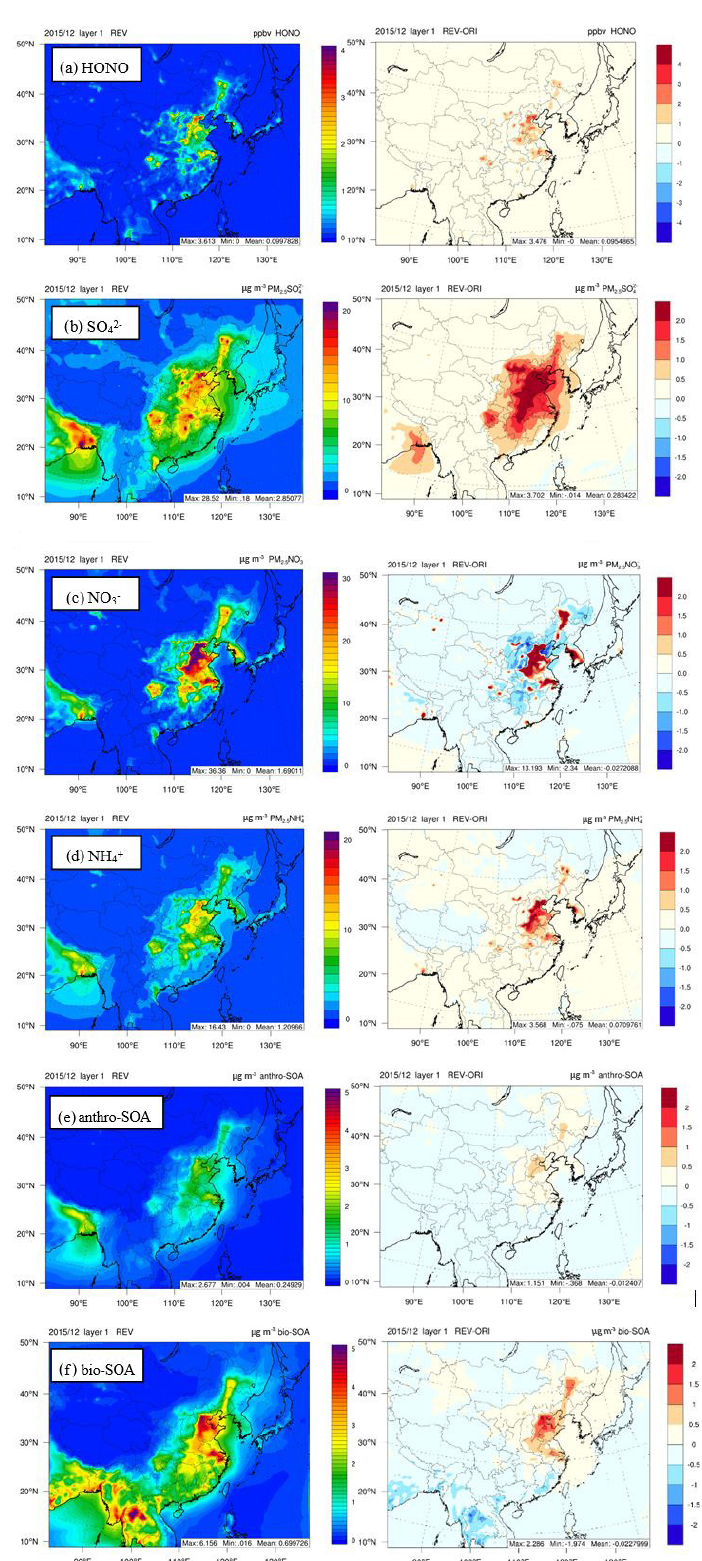
Figure 6. Spatial distributions of monthly averaged (a) HONO, (b) sulfate, (c) nitrate, (d) ammonium, (e) anthro-VOC-derived SOA, and (f) and bio-VOC-derived SOA concentrations simulated with REV and the differences (REV − ORI) between the two simulations in Decem- ber